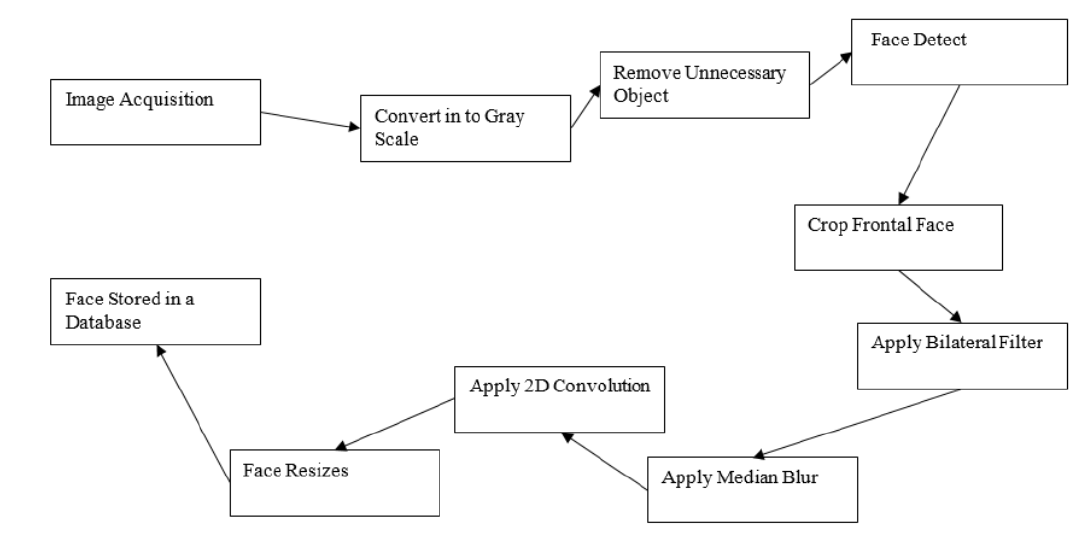
Figure 5. Proposed pre-processing steps for facial recognition (FR) methods.